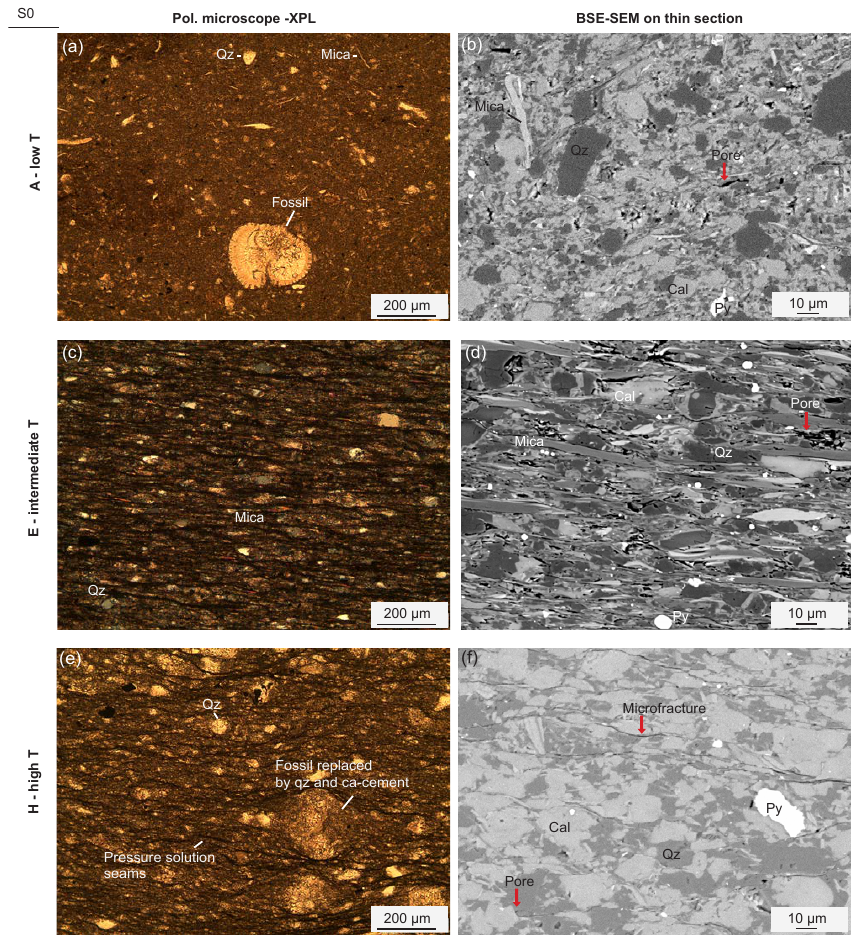
Figure 7. Thin section ( a, c, e ) and backscatter electron images ( b, d, f ) of slate microstructures collected along the N–S metamorphic gra- dient. (a, b) Sample A: low-temperature–low-strain endmember – un-deformed recrystallized fossils in a former mud matrix with randomly oriented sheet silicates. (c, d) Sample E: intermediate-temperature–intermediate-strain – sheet silicates aligned bedding-parallel. (e, f) Sam- ple H: high-temperature–high-strain endmember – showing deformed slate with recrystallized fossils and quartz in a matrix with pressure solution seams parallel to bedding. Qz: quartz; Py: pyrite; Cal: calcite; S0: